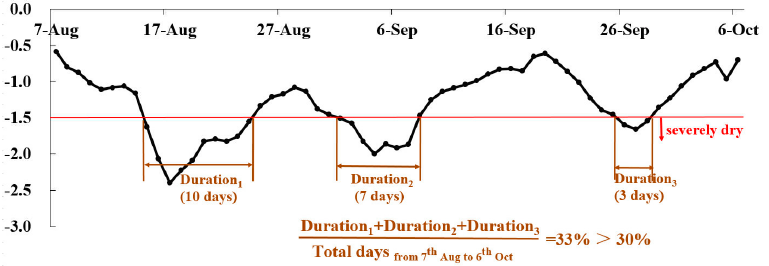
Figure 2. The 2006 summer drought event used as an example of assigning a grade to the entire drought process.